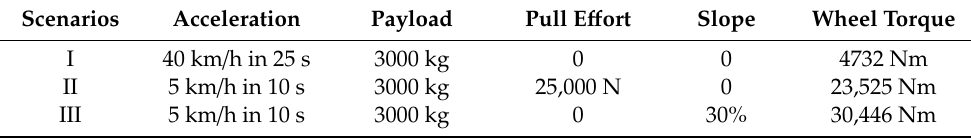
Table 2. Possible operation scenarios with maximum wheel load.